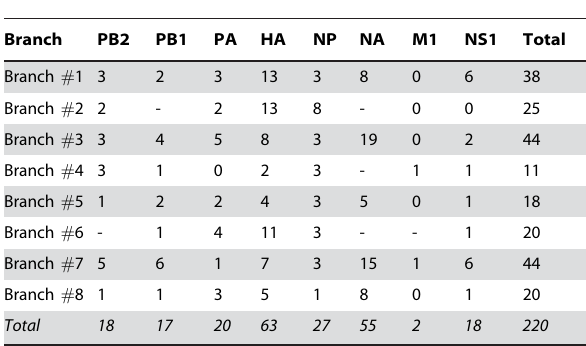
Table 1. Number of amino acid changes occurring along the main trunk branches of phylogenetic trees of each genome segment of A/H1N1